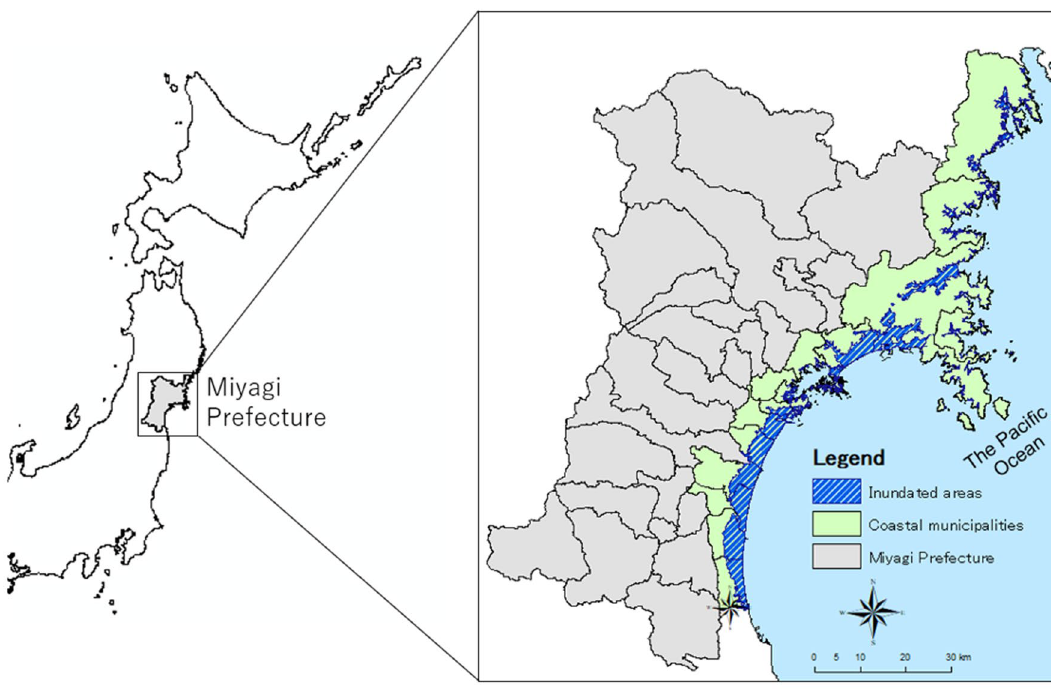
Figure 2. Study area (15 coastal municipalities) in Miyagi Prefecture, Japan. The map was created by authors using ArcGIS Pro 2.4 (https:// www. esrij. com/ produ cts/ arcgis- deskt op/ envir onmen ts/ arcgis-